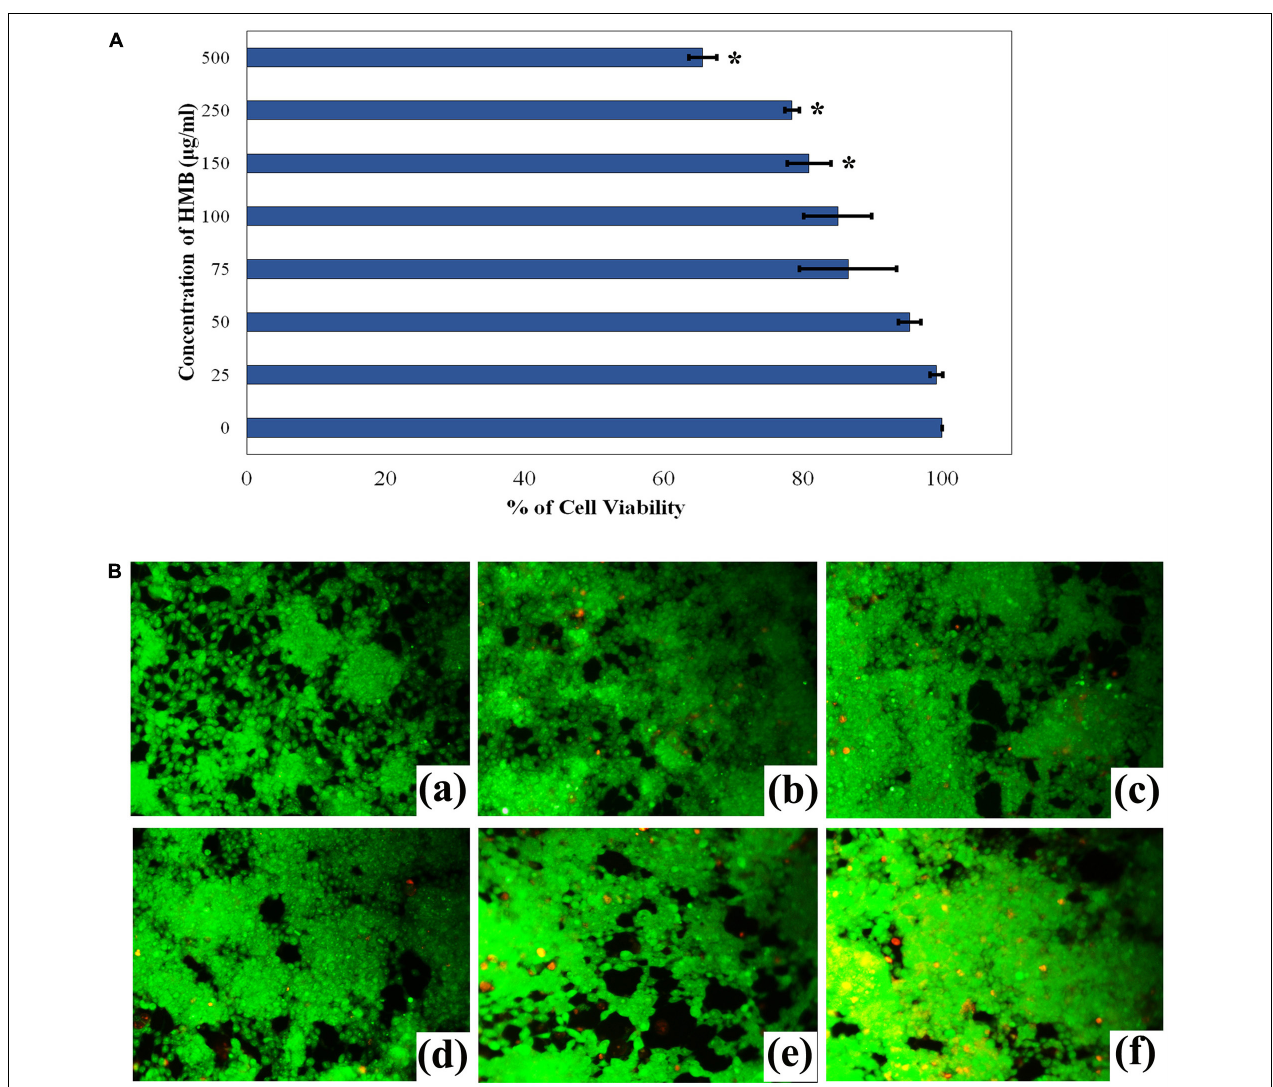
FIGURE 9 | (A) Cytotoxicity assessment of HMB in HEK-293 cells by MTT assay. Data represent mean values ( n = 3) ± standard deviation. ∗ indicates significance at P < 0.005. (B) Fluorescence microscopic images (200 × magnifications) of control (a), 25 µ g/ml (b), 50 µ g/ml (c), 100 µ g/ml (d), 250 µ g/ml, (e) 500 µ g/ml, and (f) of HMB-treated samples, which clearly depict the non-toxic nature of HMB. Green fluorescence represents viable cell lines, and red fluorescence represents dead cells. HMB,